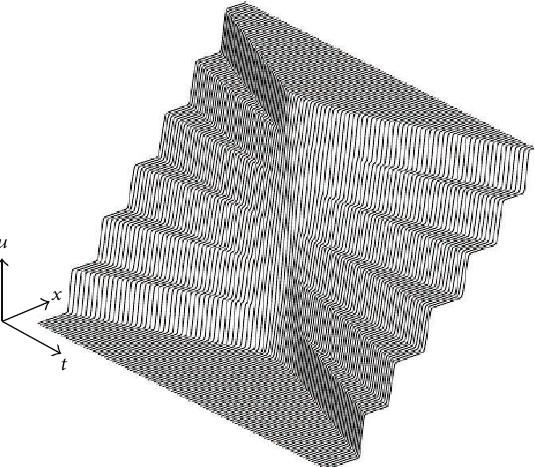
Figure 7: Interaction of 6 kinks for the nonlinearity (43).